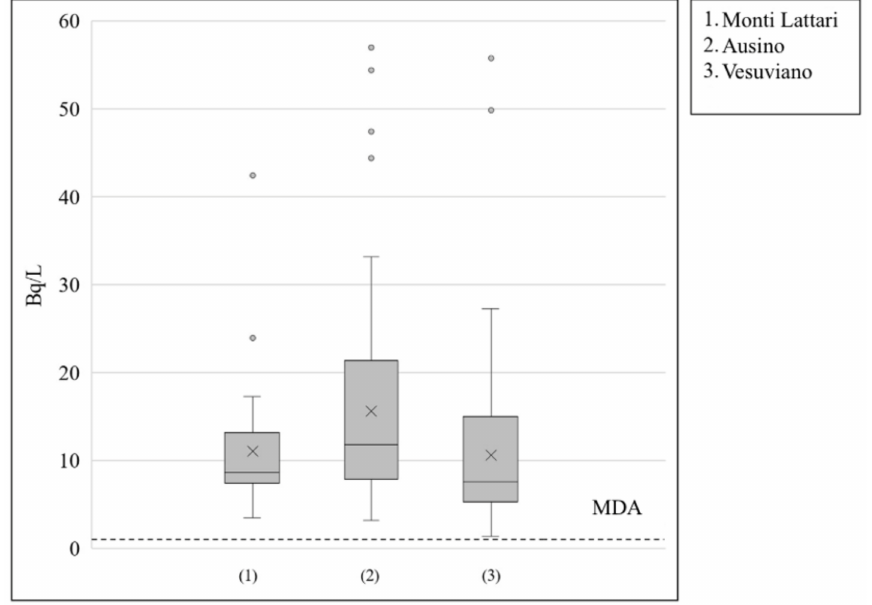
Figure 5. Variability of radon concentration of the water subsystems. The graph report median, 25th, and 75th percentile. Additionally, two horizontal lines represent the value of the MDA equal to 1 Bq/L.